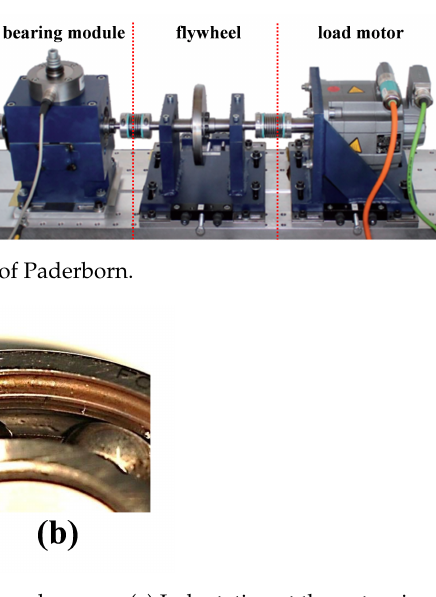
Figure 13. The realistic bearing damages. ( a ) Indentation at the outer ring. ( b ) pitting at the inner ring. Table 6. Test bench parameters.